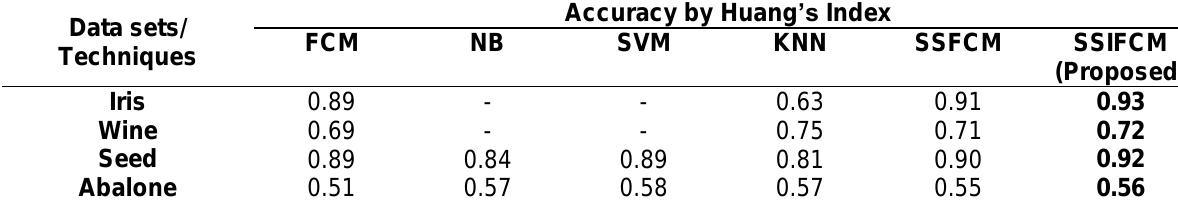
Table 4 . Comparison of the proposed technique SS IFCM on the basis of accuracy by Huang ’s